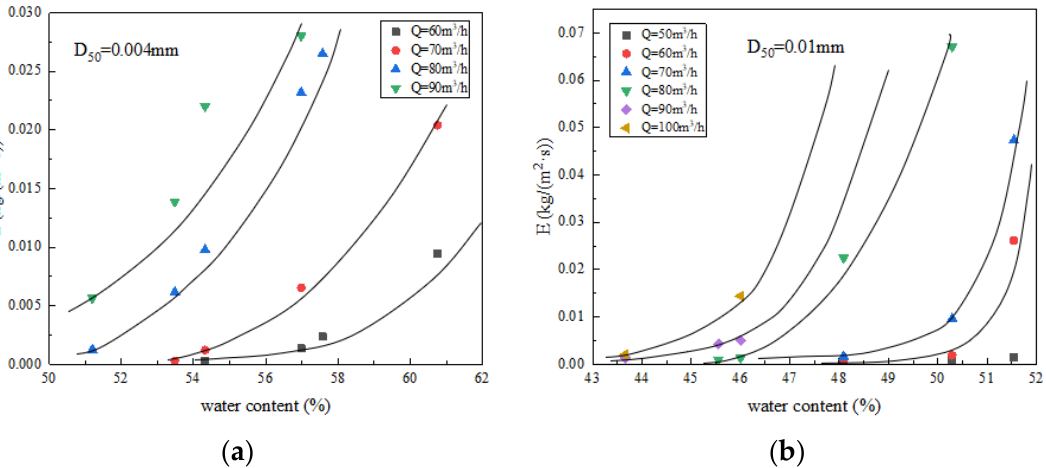
Figure 11. The relationship between water content and scouring rate. ( a ) D 50 = 0.004 mm ( b ) D 50 = 0.01 mm.